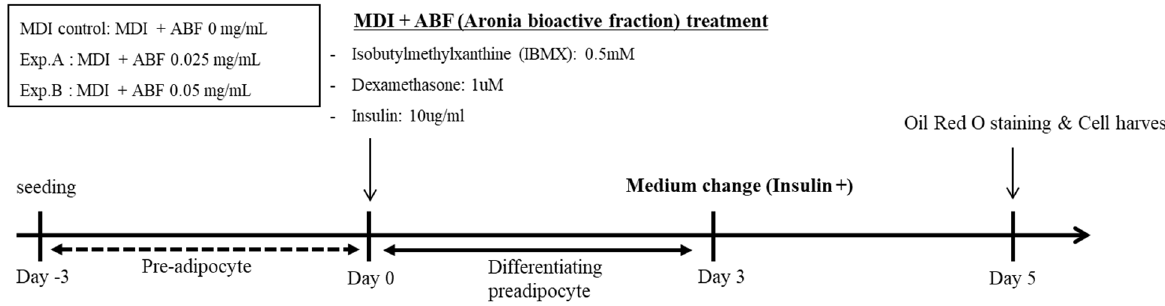
Figure 3. Schematic representation of 3T3-L1 adipocytes differentiation. MDI: 0.5 mM 3-isobutyl-1-methylxanthine, 1 µM dexamethasone, and 10 µg/mL insulin. ABF ® : Aronia bioactivity fraction.